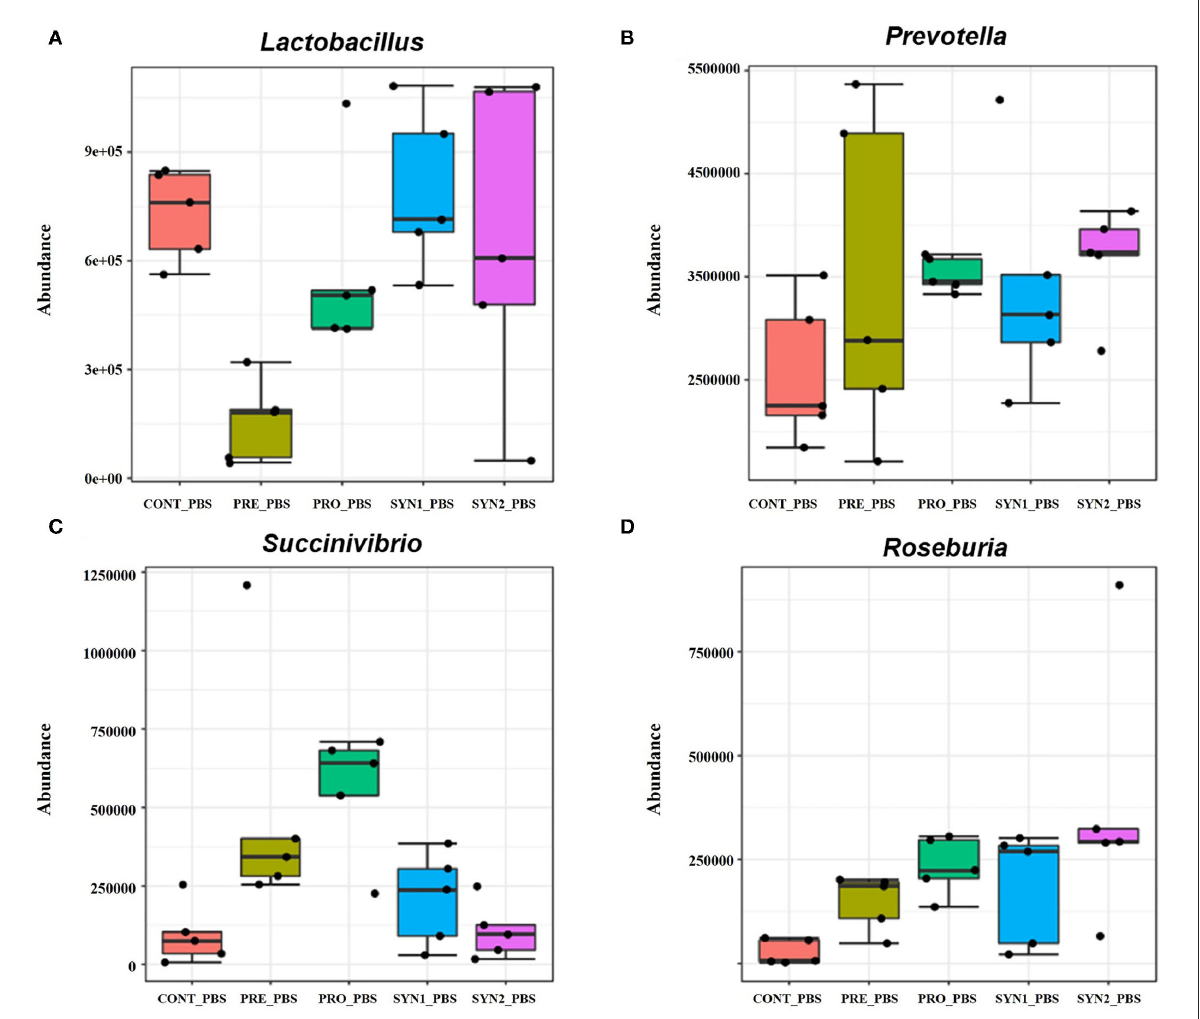
FIGURE4 Box plots showing significantly different genera in weaned pigs supplemented with prebiotics, probiotics or synbiotics without STEC challenge. Abundance of bacterial genera including (A) Lactobacillus , (B) Prevotella , (C) Succinivibrio, and (D) Roseburia were compared between PRE, PRO, SYN1 and SYN2 in comparison to the negative CONT